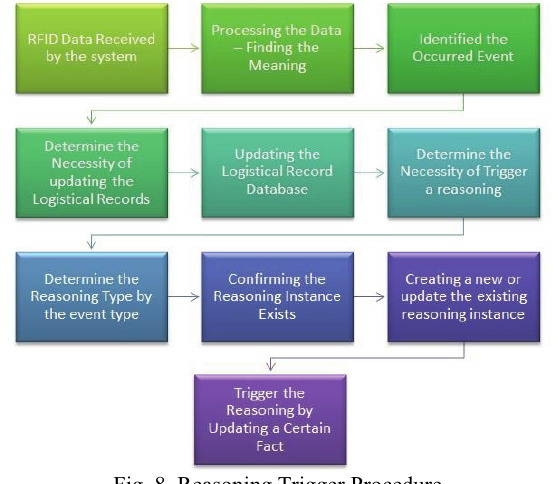
Fig. 8. Reasoning Trigger